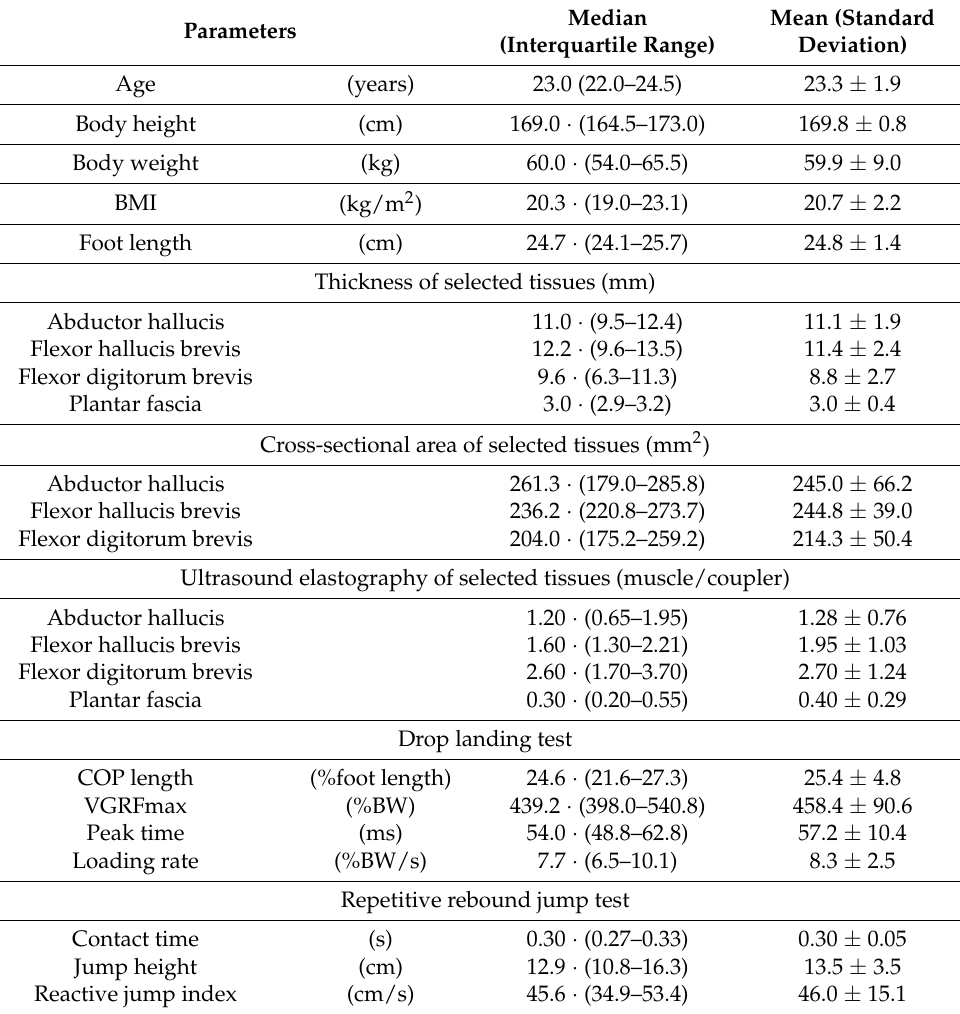
Table 1. Median (interquartile range) and Mean (standard deviation) Values of Assessed Parameters.